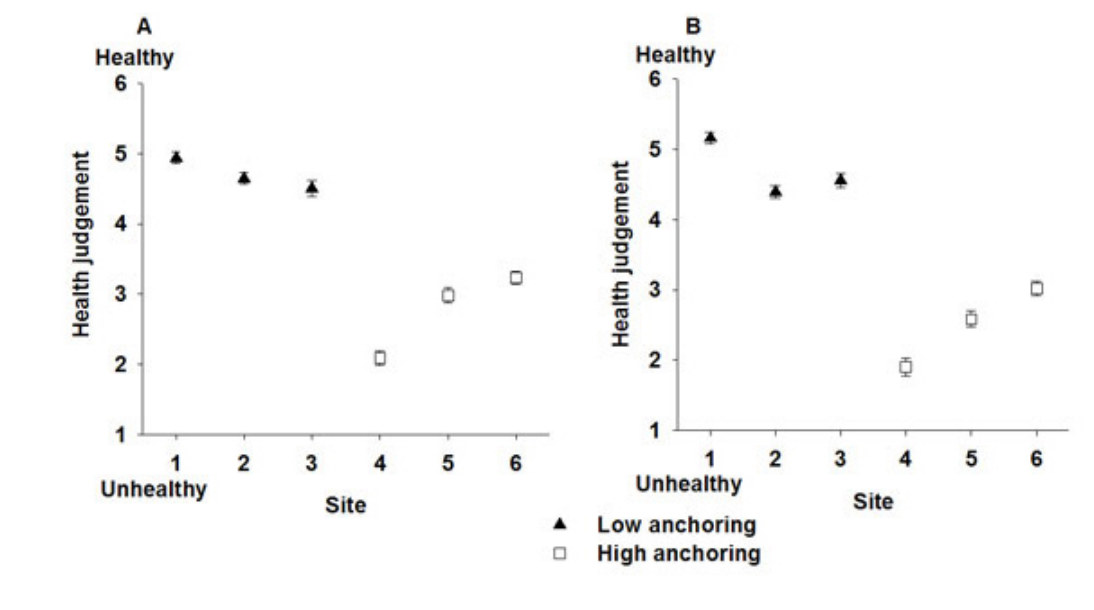
Fig. 4 . The assessment of coral reef sites associated with high and low intensities of anchoring using the mean health ratings (±SE) provided by participants who had a working association with coral reefs (A) and those who did not